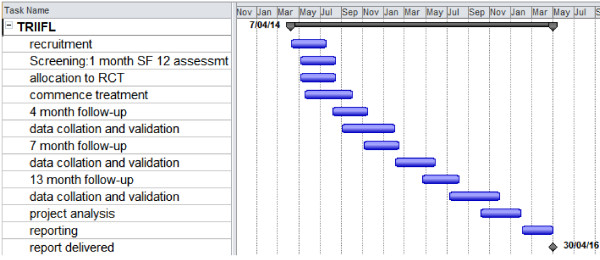
Timelines and tasks.